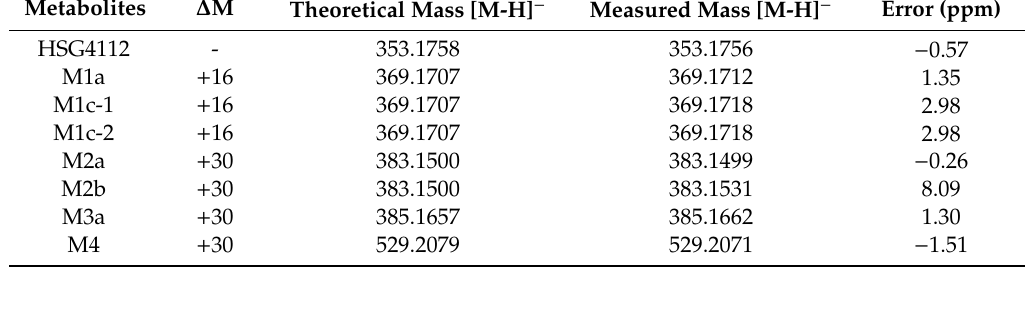
Table 5. Accurate mass data for HSG4112 and its postulated metabolites in rats.